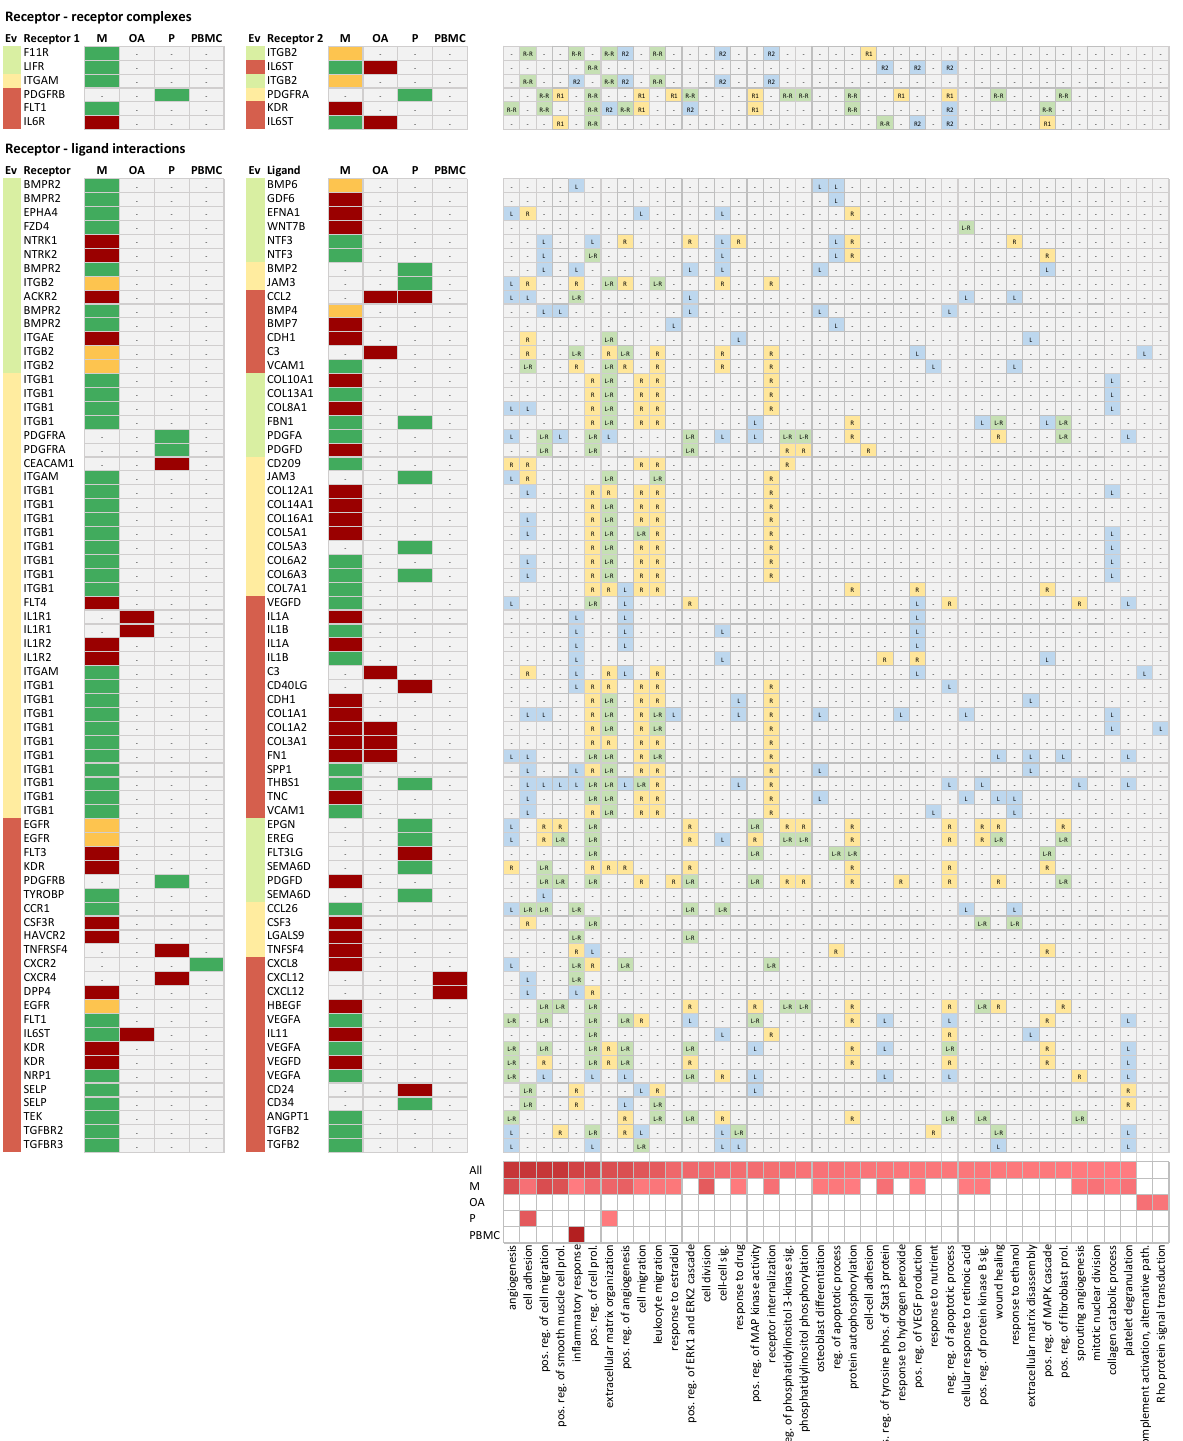
Figure 2. Receptor-receptor complexes and receptor-ligand interactions. Each row holds one receptor-receptor complex or receptor-ligand interaction, with both interactors being differentially expressed in at least one sample type in the context of PD. The evidence category (Ev) is color-coded for each protein depending on whether there is no literature information (green), some literature information (orange), or abundant literature information available in the context of PD, as described in the methods section. The columns M (mesothelial cells), OA (omental arterioles), P (peritoneal cells), and PBMC (peripheral blood mononuclear cells) indicate regulation of transcripts in the respective samples type, with red indicating upregulation, green indicating downregulation, and orange indicating up- and downregulation, in different studies in the same samples type. The heatmap on the right indicates which of the two interactors is linked to the respective enriched GO biological process. Green indicates that both interactors are assigned to the respective GO biological process, yellow